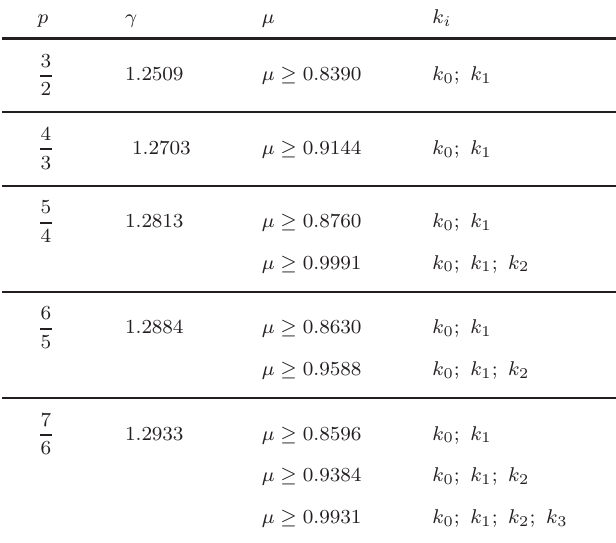
Table 1. Results of